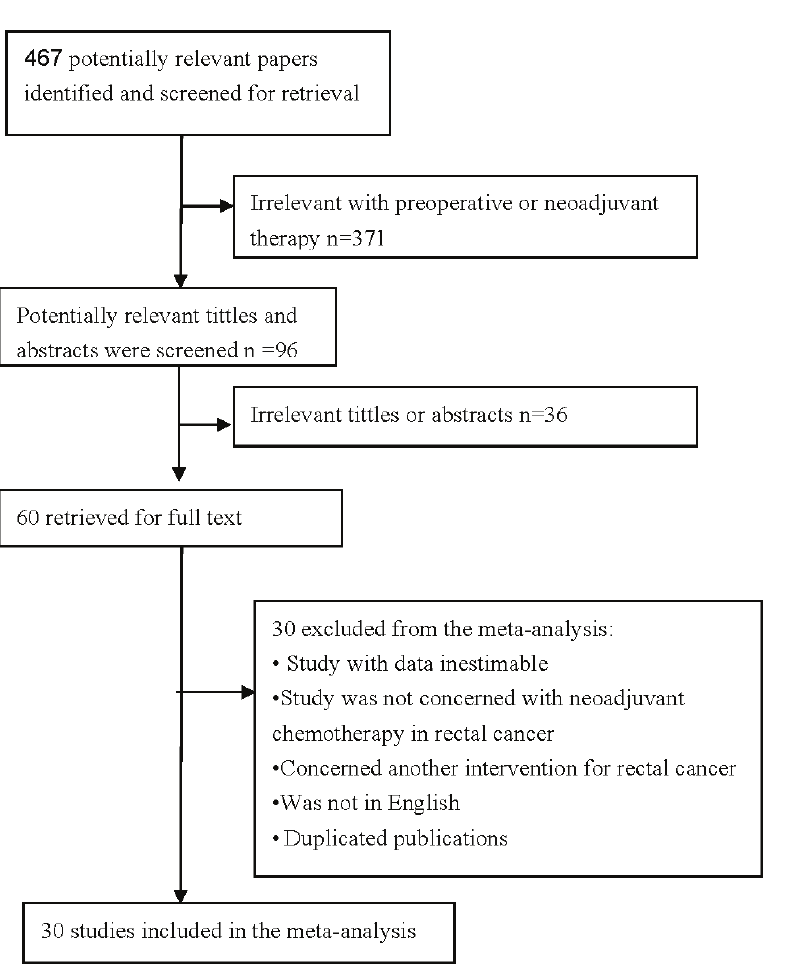
Figure 1. Improving the quality of reports of meta-analyses of randomized controlled trials; the Quality of Reporting of Meta- Analyses (QUOROM) statement flow